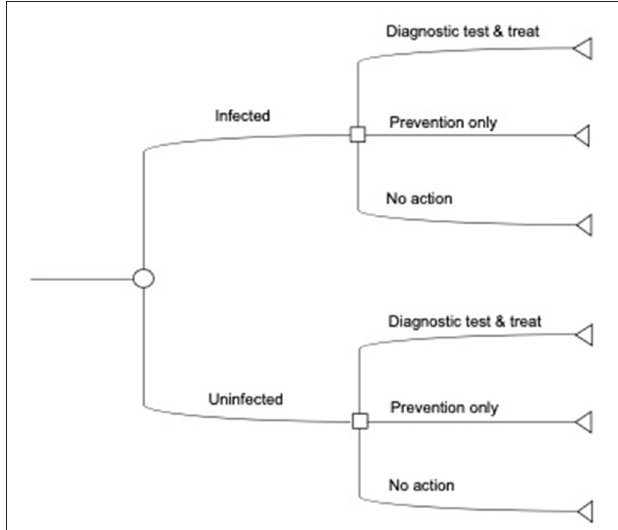
FIGURE 1 | Illustrative decision tree for diagnostic tests. The producer first observes the initial infection state in the herd. Next, the producer decides to use a diagnostic test with feed or preventative treatment, only apply preventative treatments, or take no action and incur post-infection costs and losses. The decision tree here does not show the costs associated with each decision, the probability of infection, or the decision over multiple time periods (see Supplementary Materials